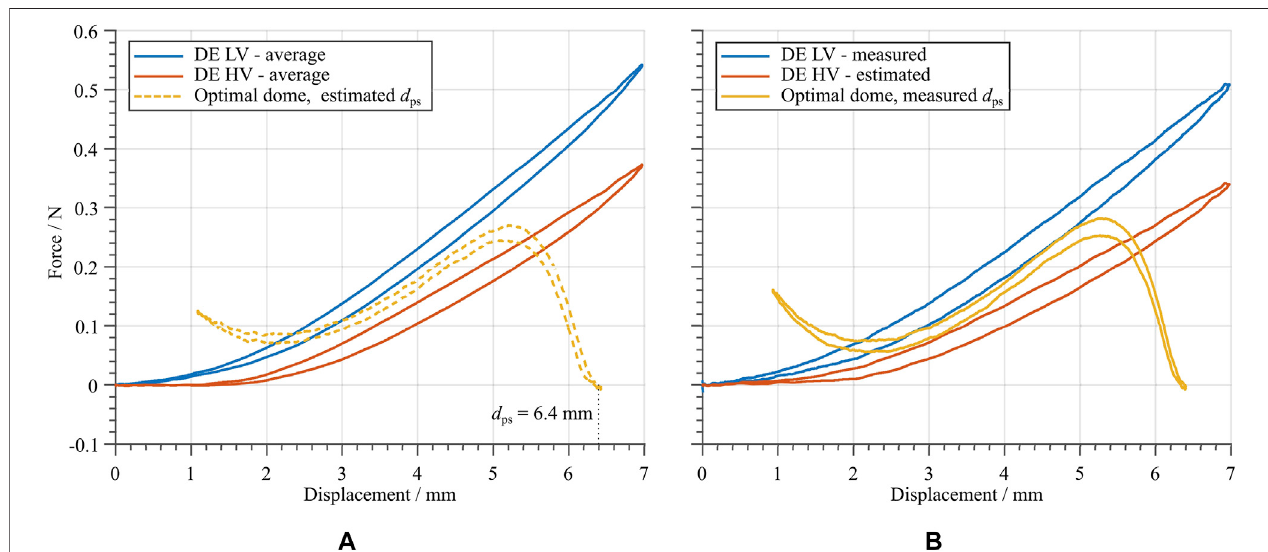
FIGURE 10 | (A) Measured force-displacement curve of the dome, whose geometry is determined based on the optimization method in Section 4 , together with theaverageDEcurvesfrom Figure7 ,inordertocheckthesuitabilityofthedesignandtodeterminetheamountofpre-stretch. (B) MeasuredDELVcurveandestimated DE HV curve, together with a manufactured dome with the optimized geometry and value of d ps determined by a laser measurement.